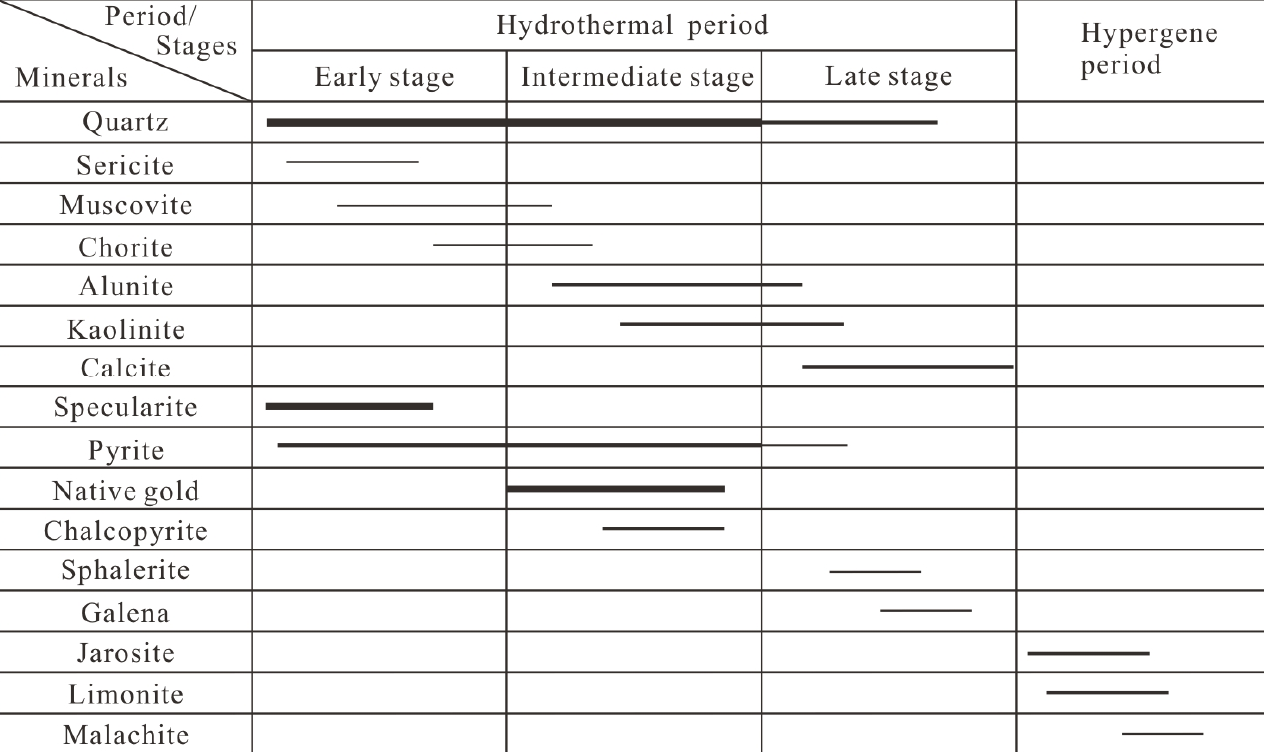
Figure 4. Mineral paragenesis of the Harla gold deposit.